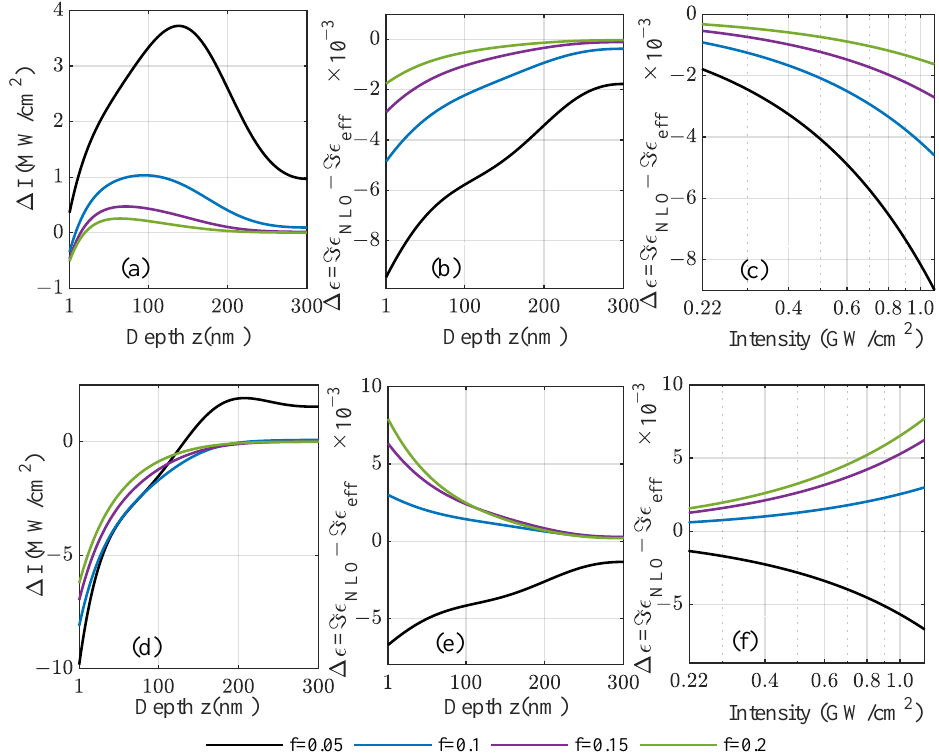
Figure 7. As a function of the position z inside a 300 nm composite film for frequencies below the Mie resonance of gold nanoparticles, the ( a , d ) change in total intensity ∆ I = I NLO − I lin (forward and backward scattering) and ( b , c , e , f ) change in the imaginary part of the nonlinear permittivity ∆ Im (cid:101) = Im (cid:101) − Im (cid:101) NLO eff are shown for gold with input values fitted to available experiments [20]. Cases with saturated and induced absorption are observed. The set frequencies are 2.15 eV in the upper panel and 2.20 eV in the lower panel. The incident power density is 1.6 GW / cm 2 .